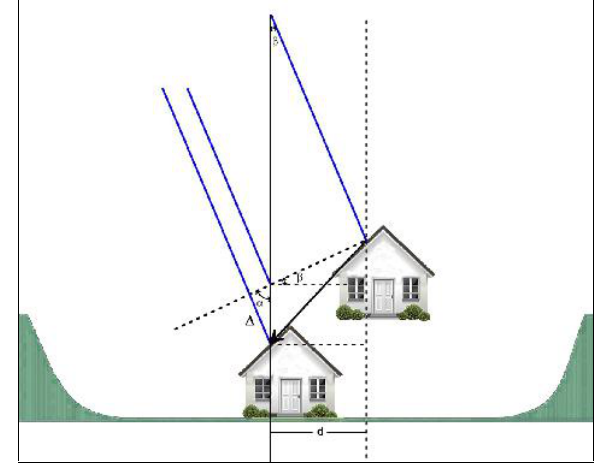
Figure 5. The effects of a 3D displacement on the SAR measurements.